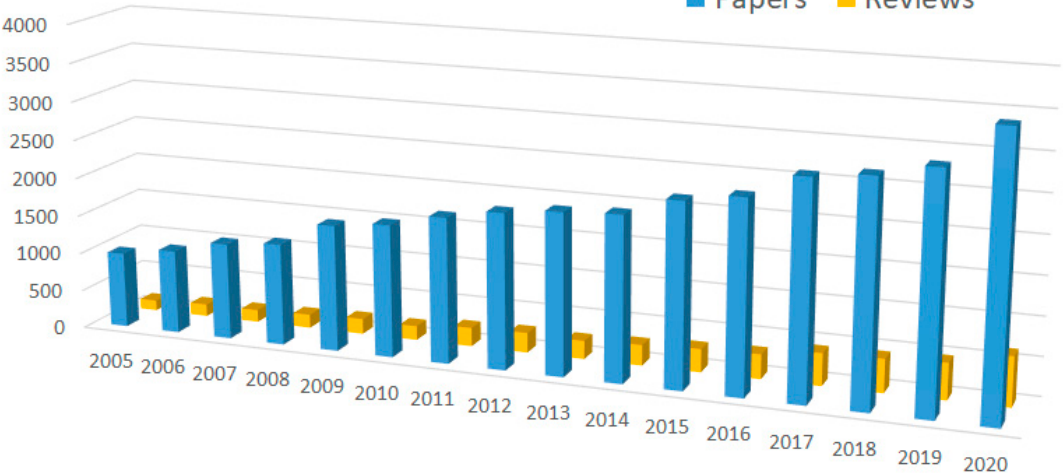
Figure 1. Published research paper reported in the Web of Science (https://www.webofscience.com/wos/woscc/basic-search (accessed on 16 December 2021)) between the years 2005 and 2020, containing the words “antimicrobial peptide” in the topic.